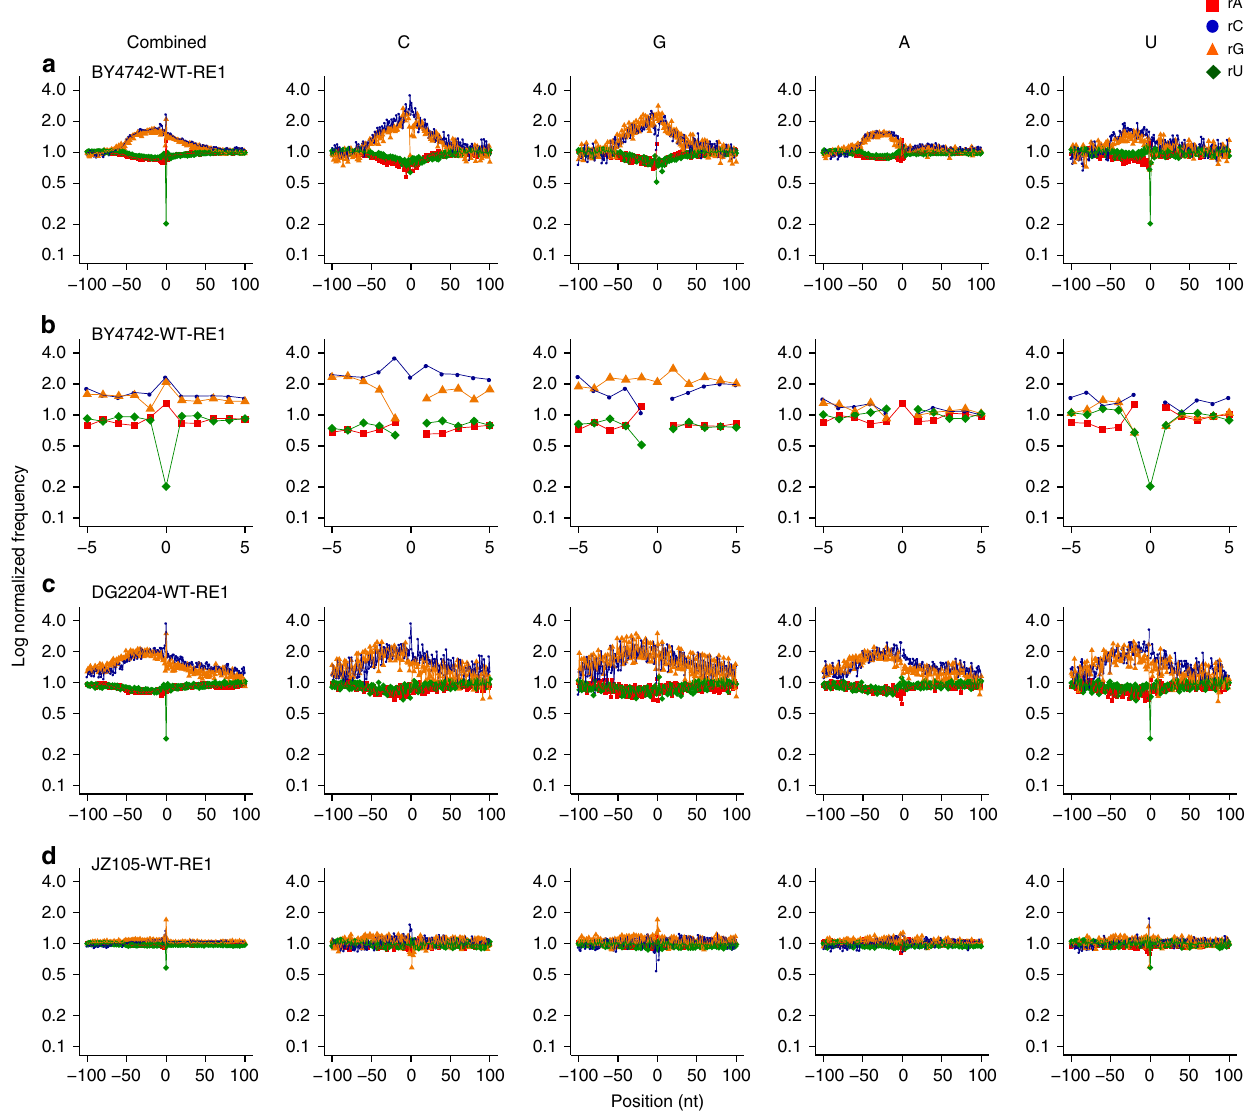
Fig. 3 Sequence context of rNMPs in wild-type yeast mtDNA. Shown are examples of combined and single rNMP plots of normalized nucleotide frequencies relative to mapped positions of rNMPs from examples of mitochondrial ribose-seq libraries. a Zoom-out and b zoom-in plots for mitochondrial library BY4742-WT-RE1-FS104 of S. cerevisiae WT cells. c Zoom-out plots for mitochondrial library DG2204-WT-RE1-FS108 of S. paradoxus WT cells. d Zoom-out plots for mitochondrial library JZ105-WT-RE1-FS94 of S. pombe WT cells. Position 0 on the x -axis represents the site of rNMP incorporation, − and + positions represent upstream and downstream dNMPs, respectively. The y -axis shows the frequency of each type of nucleotide present in the ribose-seq data normalized to the frequency of the corresponding nucleotide present in the reference genome of the indicted yeast species. Red square, A; blue circle, C; orange triangle, G; and green rhombus,